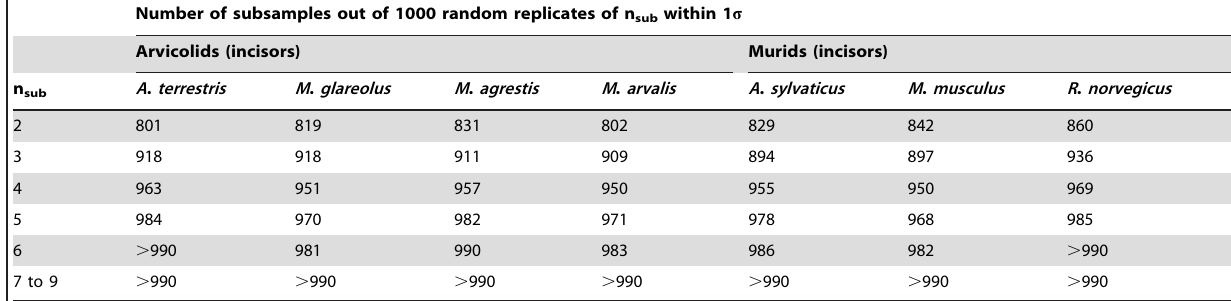
Table 4. Results of the bootstrap analysis of d 18 O CO3 for rodent incisors (n=10 in each species).